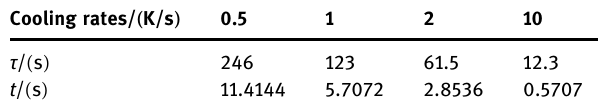
Table 5: Time deviation for the calculation at different cooling rates Cooling rates/ ( K/s